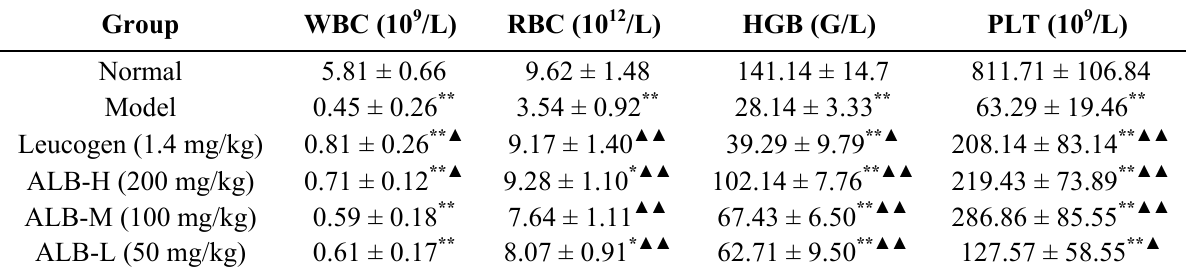
Table 1. The effects of lingonberry anthocyanins on blood cell analysis of radiation in mice